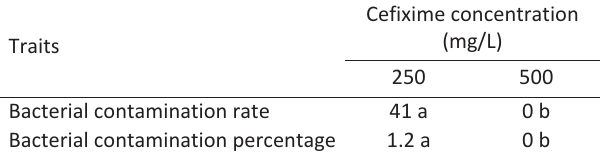
Table 5 ­ Evaluation of decreasing of cefixime on BCR and BCP after ten days